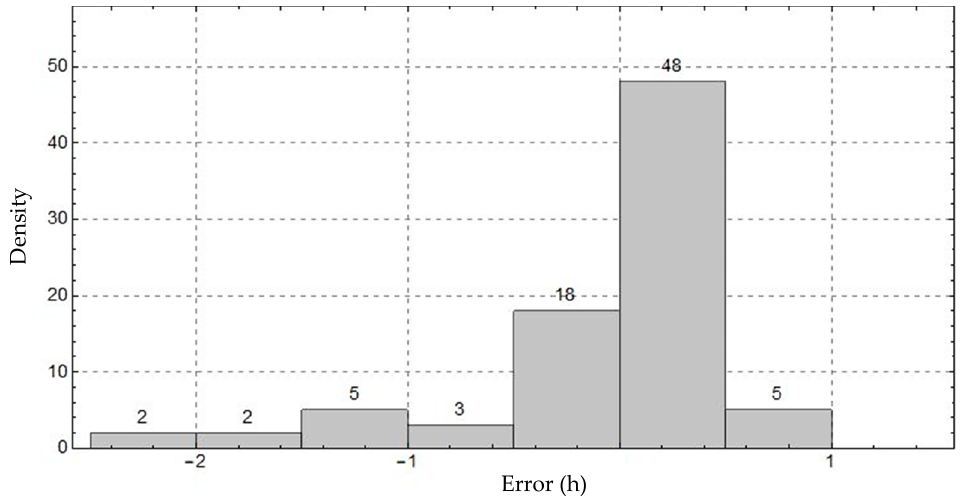
Figure 14. Relative frequency of divergences of the sunshine duration (SD) results between the proposed system and official data for the city of Campina Grande, Brazil.